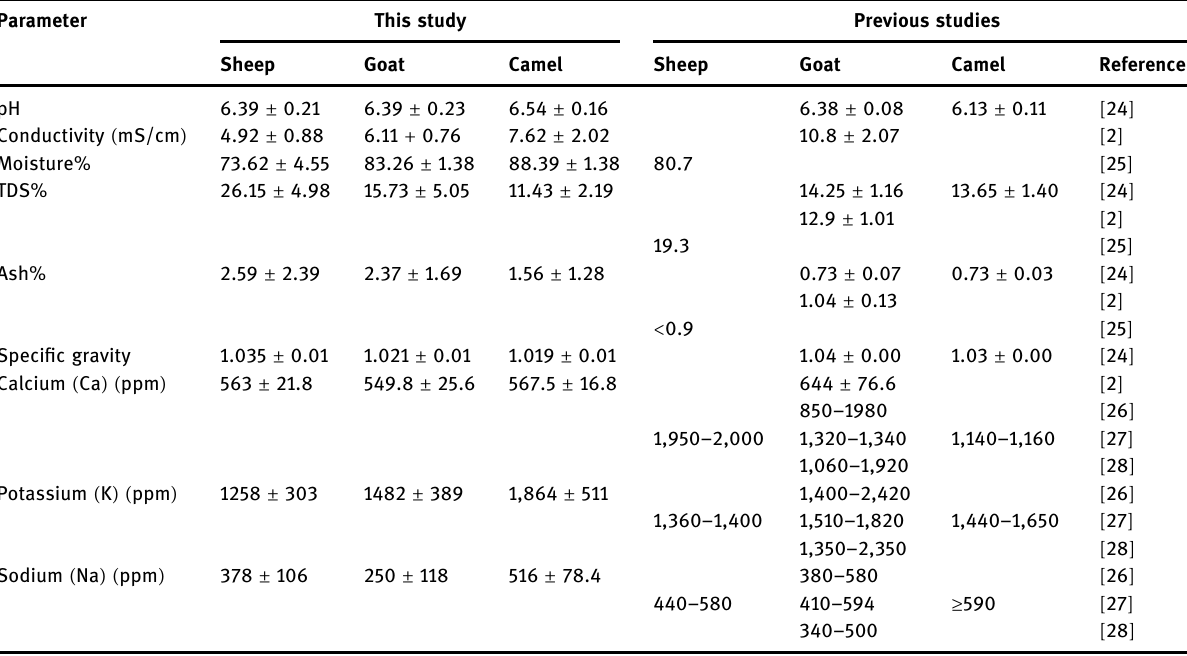
Table 4: Comparison between the fi ndings of this study and the reviewed literature without considering the altitude e ff ect